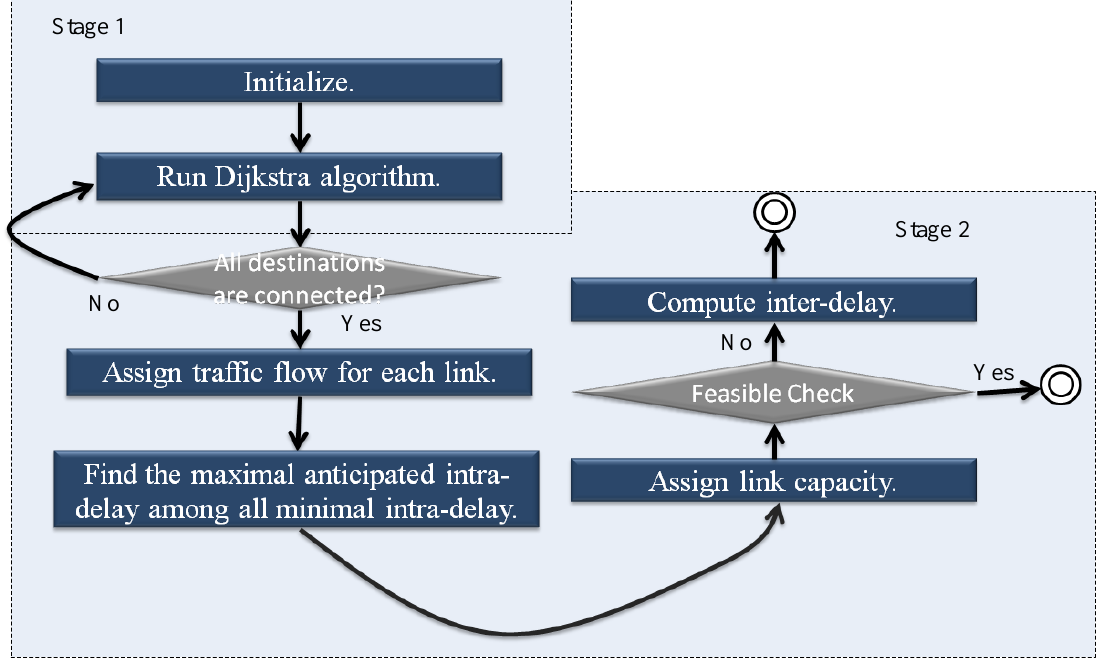
Figure 10. Flow chart of getting primal feasible solution.